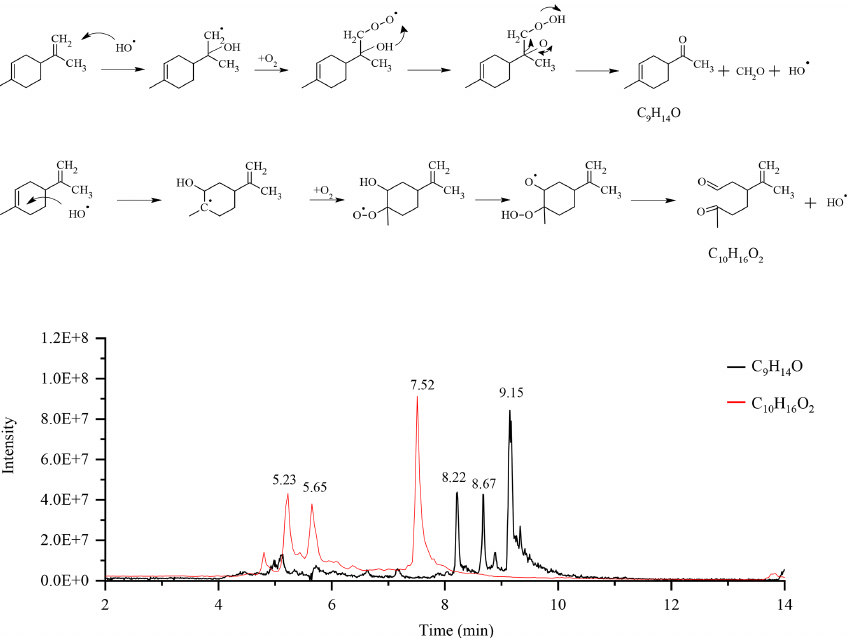
Figure 6. Oxidation of limonene according to the Waddington mechanism and chromatograms of the compounds obtained: C 9 H 14 O and C 10 H 16 O 2 (APCI +